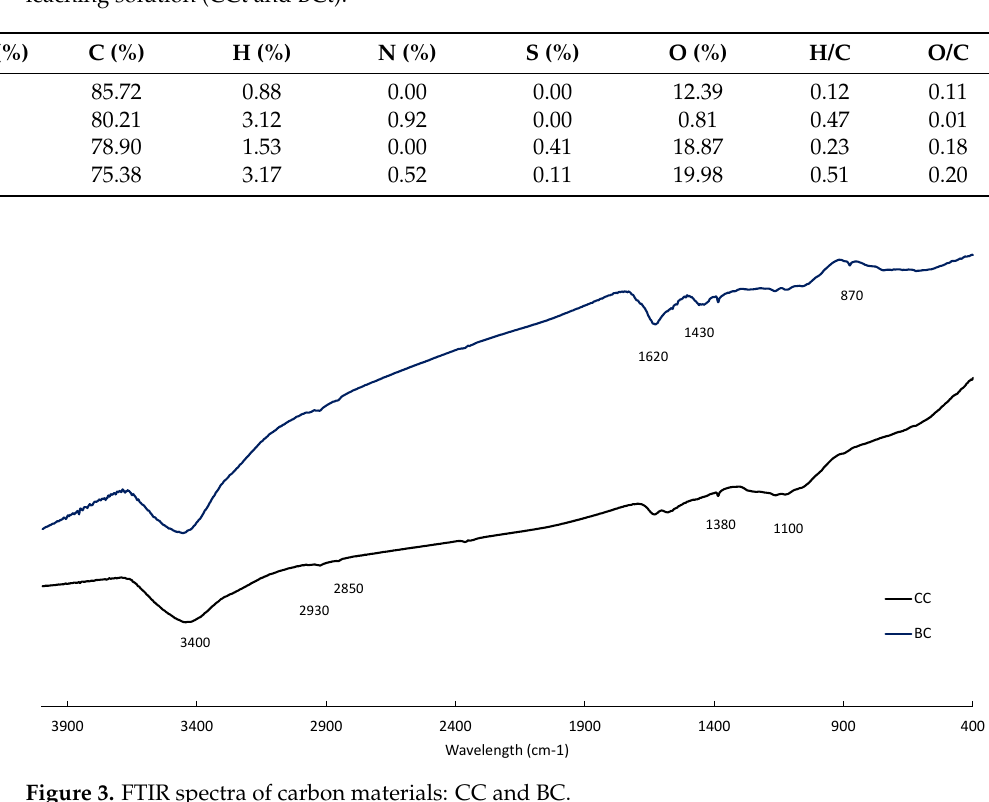
Table 2 . Main properties of carbon materials (CC and BC) and carbon materials after treatment with leaching solution (CCt and BCt) .